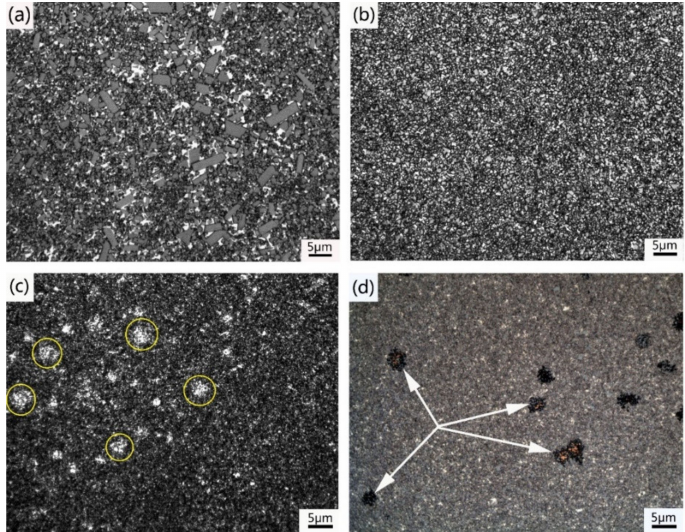
Figure 3. Optical images showing the microstructures of sintered cemented carbides. ( a ) WC–10Co; ( b ) WC–10Co–0.8Cr 3 C 2 ; ( c ) WC–10Co–0.8VC; ( d )